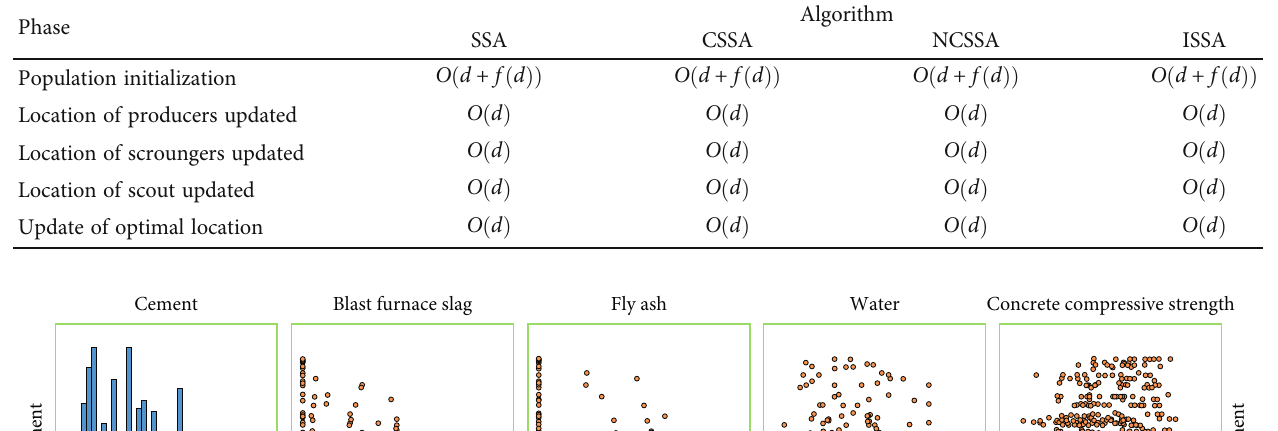
Table 4: Time complexity comparison of algorithm.